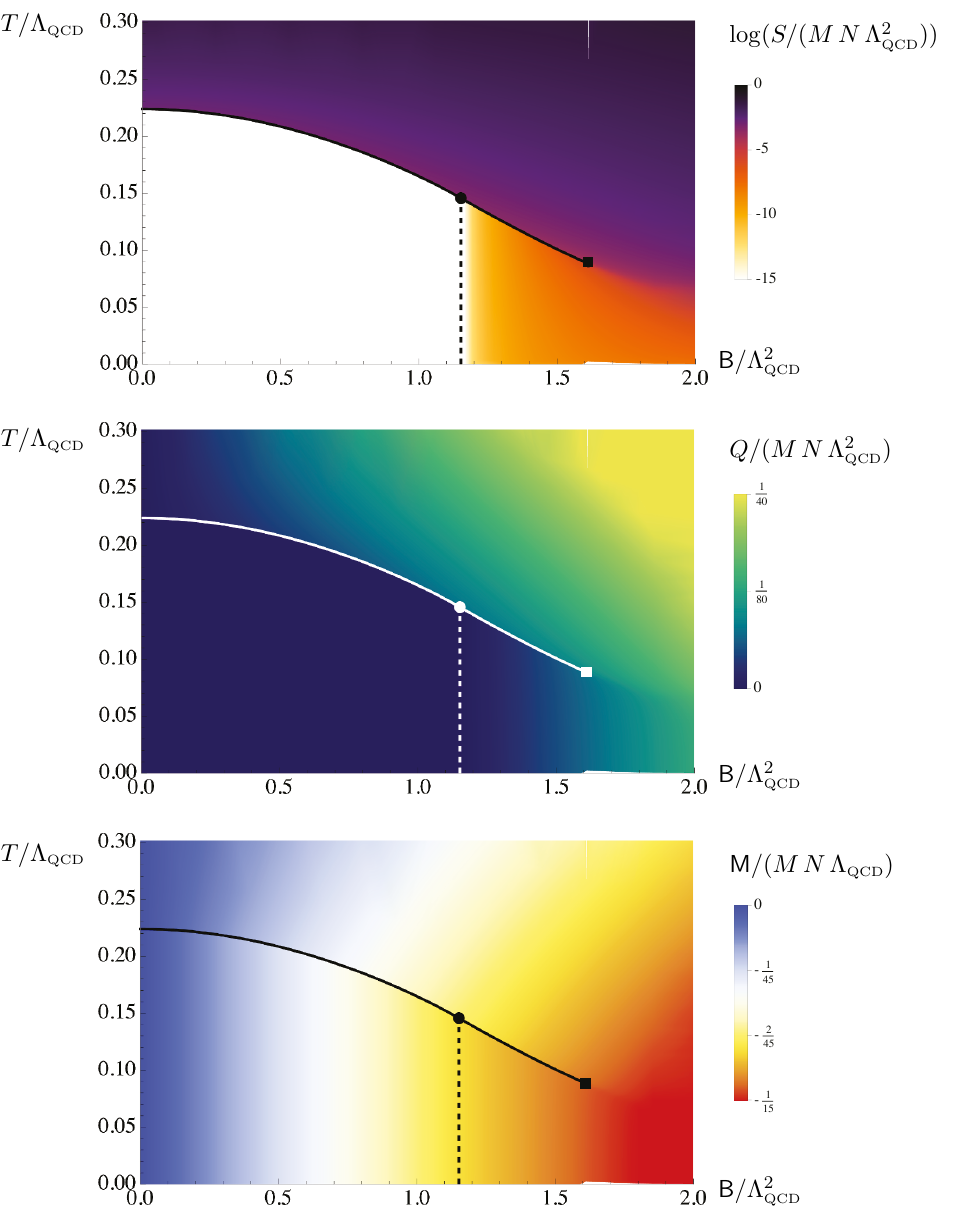
Figure 11. Density plots of the logarithm of the entropy density ( top ), charge density ( middle ) and magnetization ( bottom ) as a function of the external magnetic field and temperature. The solid curves correspond to the line of first order phase transitions between the plasma and the confining phase (when B < B ) and between different states of the plasma (when B triple These curves end at a critical point, represented by a square. Finally, the dashed vertical lines correspond to second order confinement/deconfinement phase transitions between the confining solution and the low-temperature plasma state. The triple point (4.12) is represented by a circle, where the three phases may